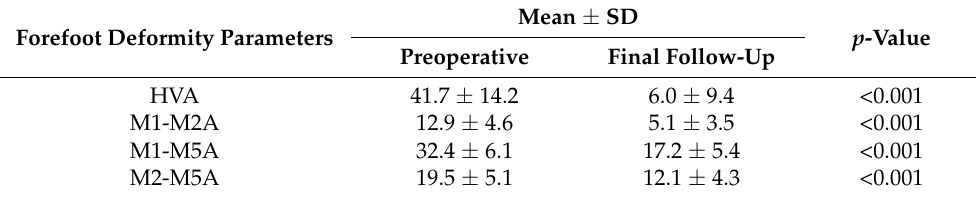
Table 3. Changes in radiographic angle measurements in the forefoot.